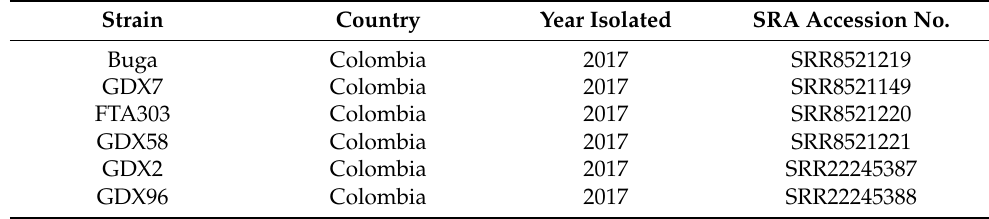
Table 2. Information on the strains used in this